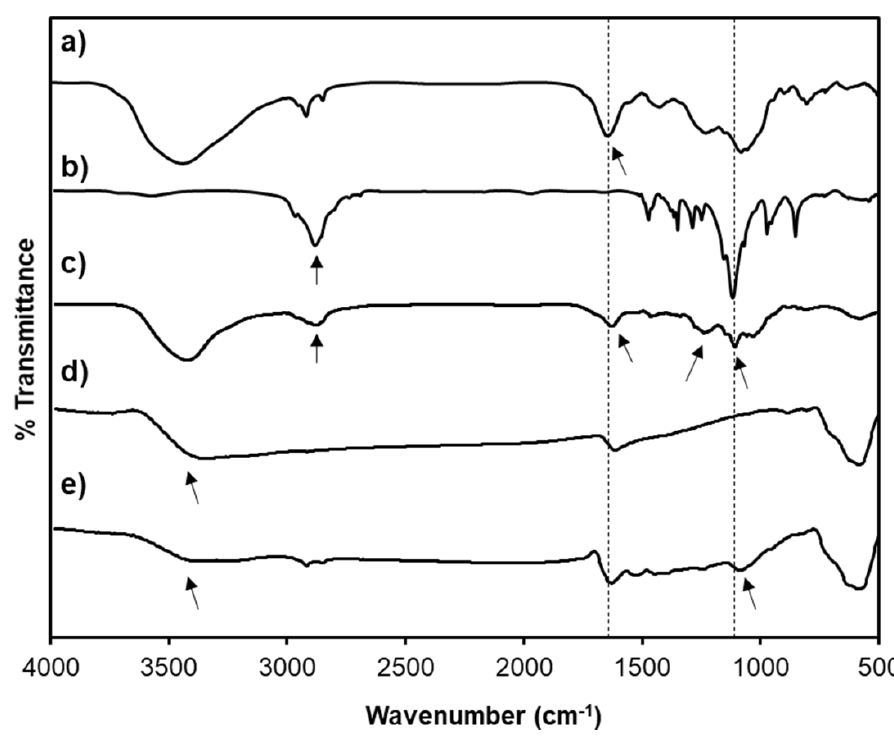
Figure 3. FT-IR spectra of heparin ( a ); Poloxamer ( b ); HP ( c ); SPIONs ( d ); and SPION@HP ( e ).